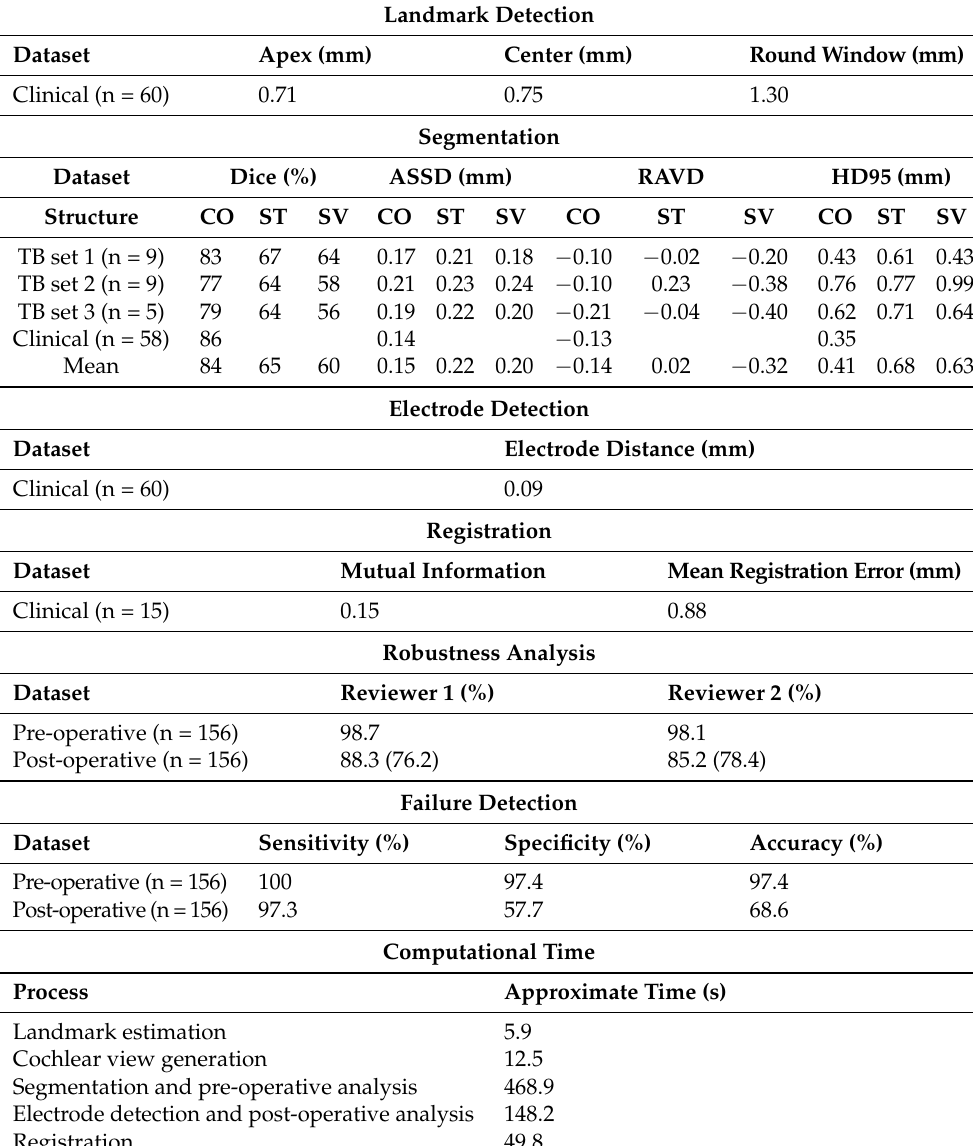
Table 2. Accuracy and robustness analysis for each pipeline process. ASSD: average symmetric surface distance, RAVD: relative absolute volume difference, HD95: 95% Hausdorff